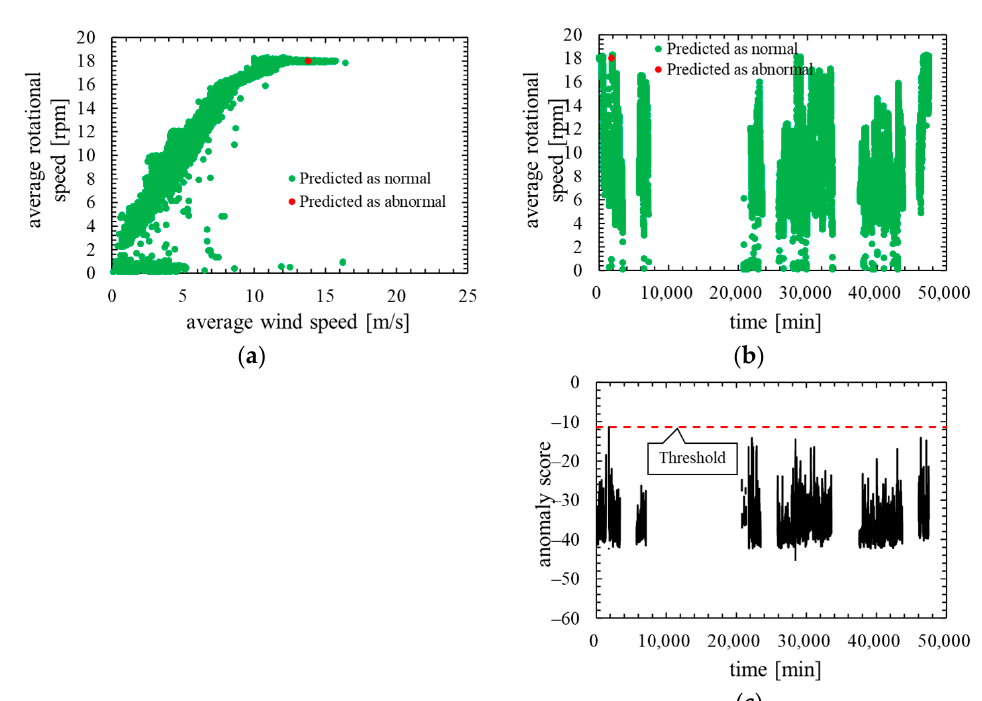
Figure 10. Training data of the model in which the number of mixture components K was 64 (the threshold is 100th percentile’s value): ( a ) wind speed rotational speed characteristic; ( b ) time characteristics of rotational speed; ( c ) time characteristics of anomaly score.